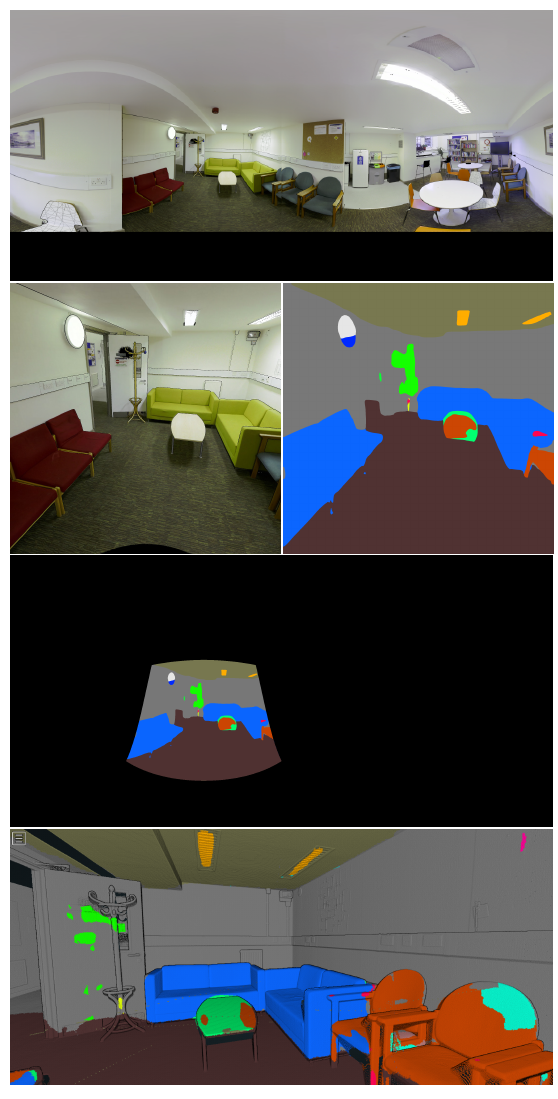
Figure 2. Data at different stages of the pipeline. Row 1 Panorama image created from TLS point cloud with the co-registered RGB information. Row 2 Example of tangential image in rectilinear projection and segmentation result. Row 3 The semantic segmentation output re-projected from tangential to equirectangular. The full map is given in Figure 6. Row 4 Point cloud rendering with labels from merged equirectangular segmentation